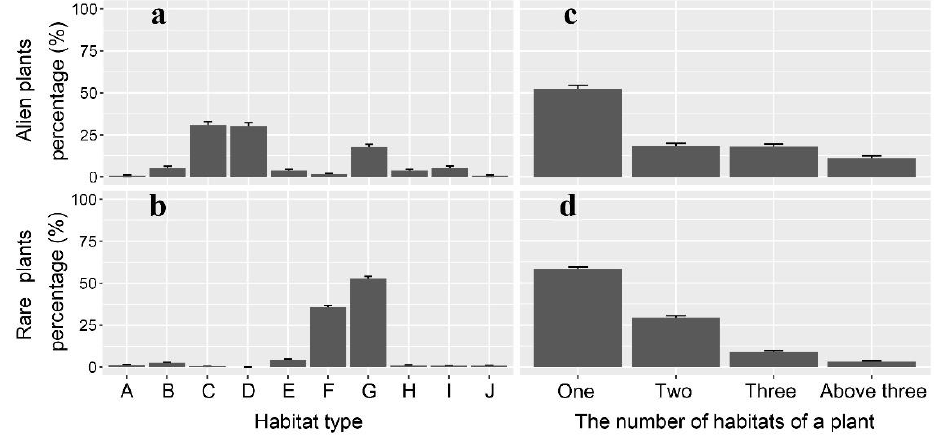
Figure 4. Percentage of habitat types and the number of habitats of a plant. Percentage of habitat type of alien ( a ) and rare plants ( b ); percentage of the number of habitats of a plant of alien ( c ) and rare plants ( d ). A, desert or desert steppe; B, steppe or dry hillside; C, wayside, near the village or wasteland;